Question: What kind of plot is shown here?
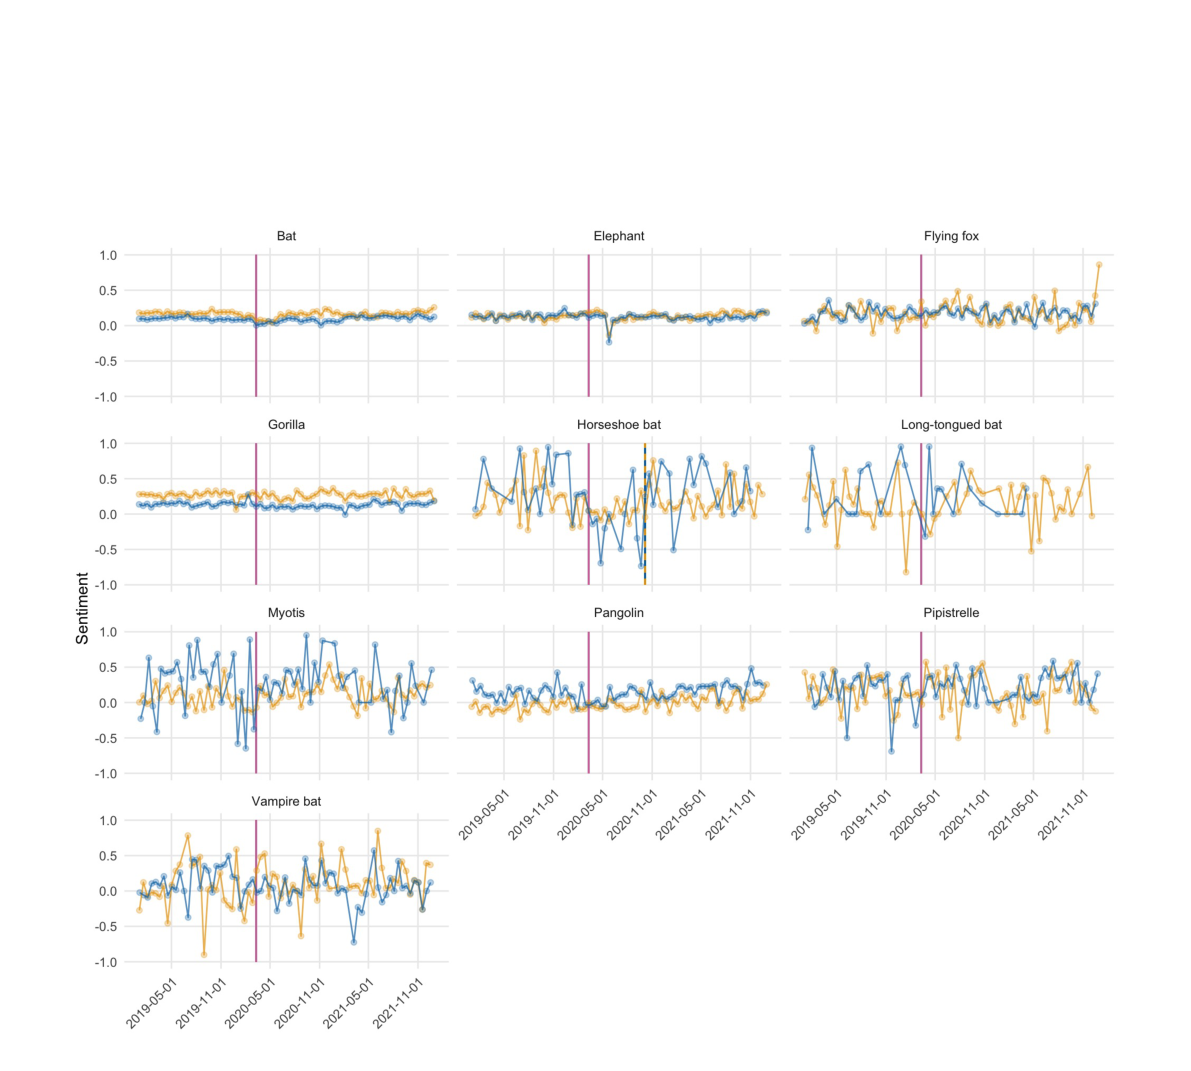
Answer: line